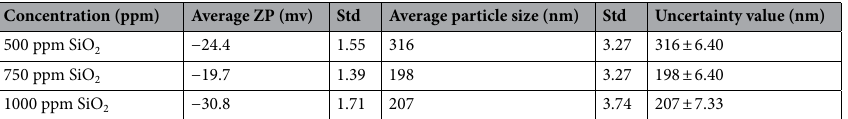
Table 13. ZP and DLS results of OLSSW with uncertainty in the presence of monovalent ions with various NPs concentrations at pH 8.